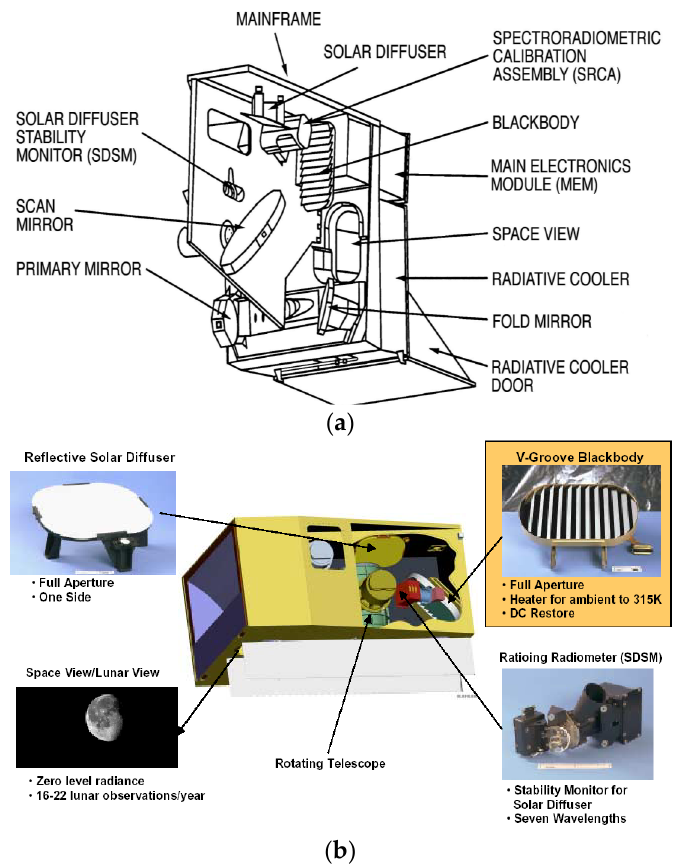
Figure 1. Instrument setup with on-board calibrators ( a ) MODIS; ( b ) VIIRS [1,2].